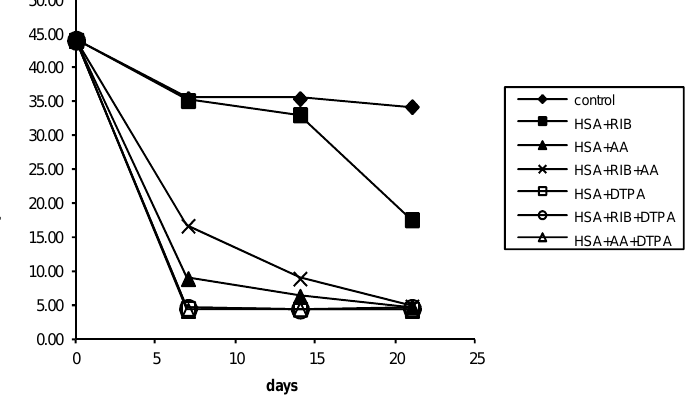
Figure 9. Percentage of alpha-helix conformation in HSA treated with ribose, AA, and DTPA and their combinations, as evaluated by CD.